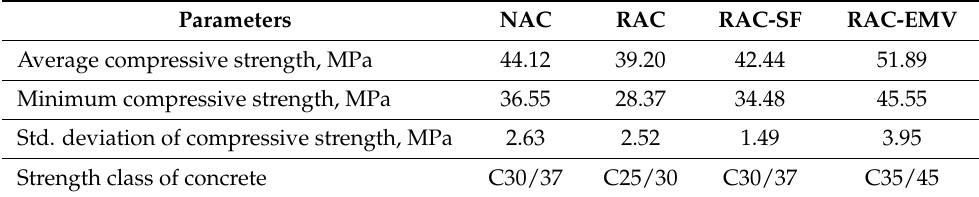
Table 6. Compressive strength and strength class of